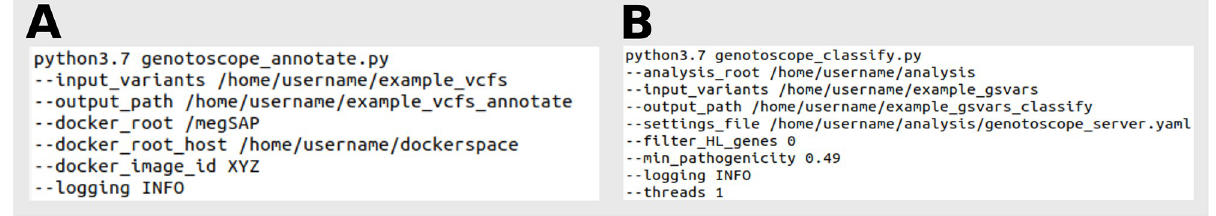
Fig 4. Command line examples for the two commands of GenOtoScope. (A) Annotate all variants presented in VCF files, in input folder, using megSAP application and save results in GSvar files. (B) Classify all variants presented in GSvar files based on ACMG guidelines specified for HL.